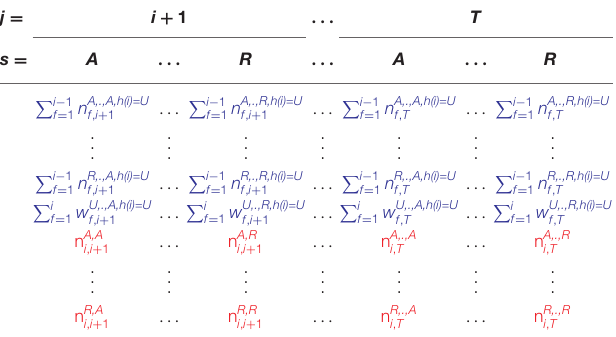
TABLE 3 | Table used for testing the mixture property of partial observations at occasion i in a capture-recapture experiment with T occasions where individuals can be in any of R live states.